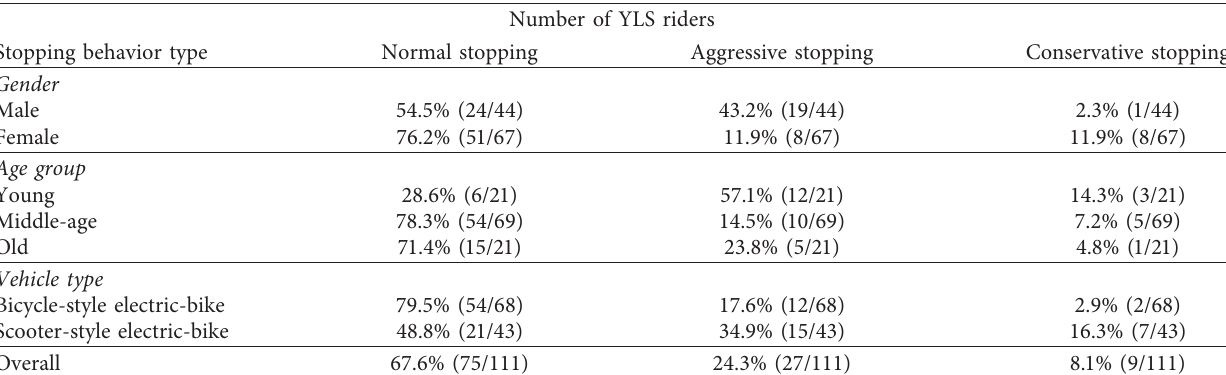
Table 3: Statistics of yellow-light stopping behaviour by each subcategory.